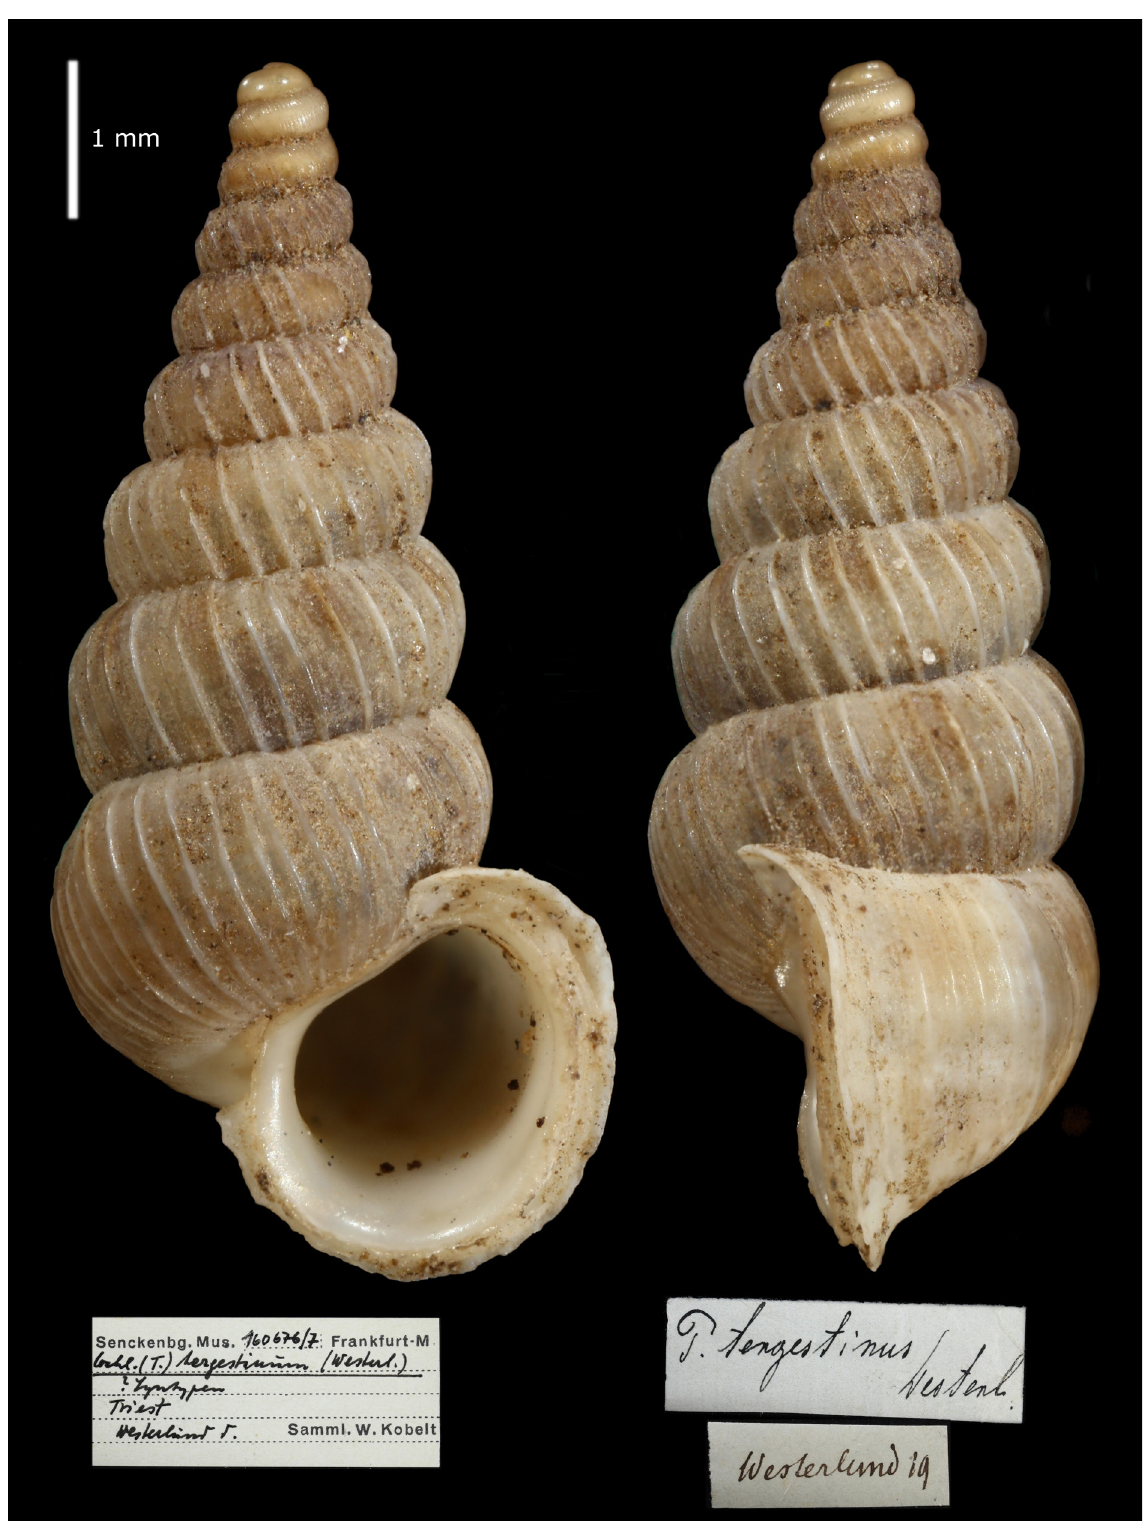
Fig. 30. Cochlostoma ( Clessiniella ) tergestinum (Westerlund, 1878), syntype at the Senckenberg Museum Frankfurt